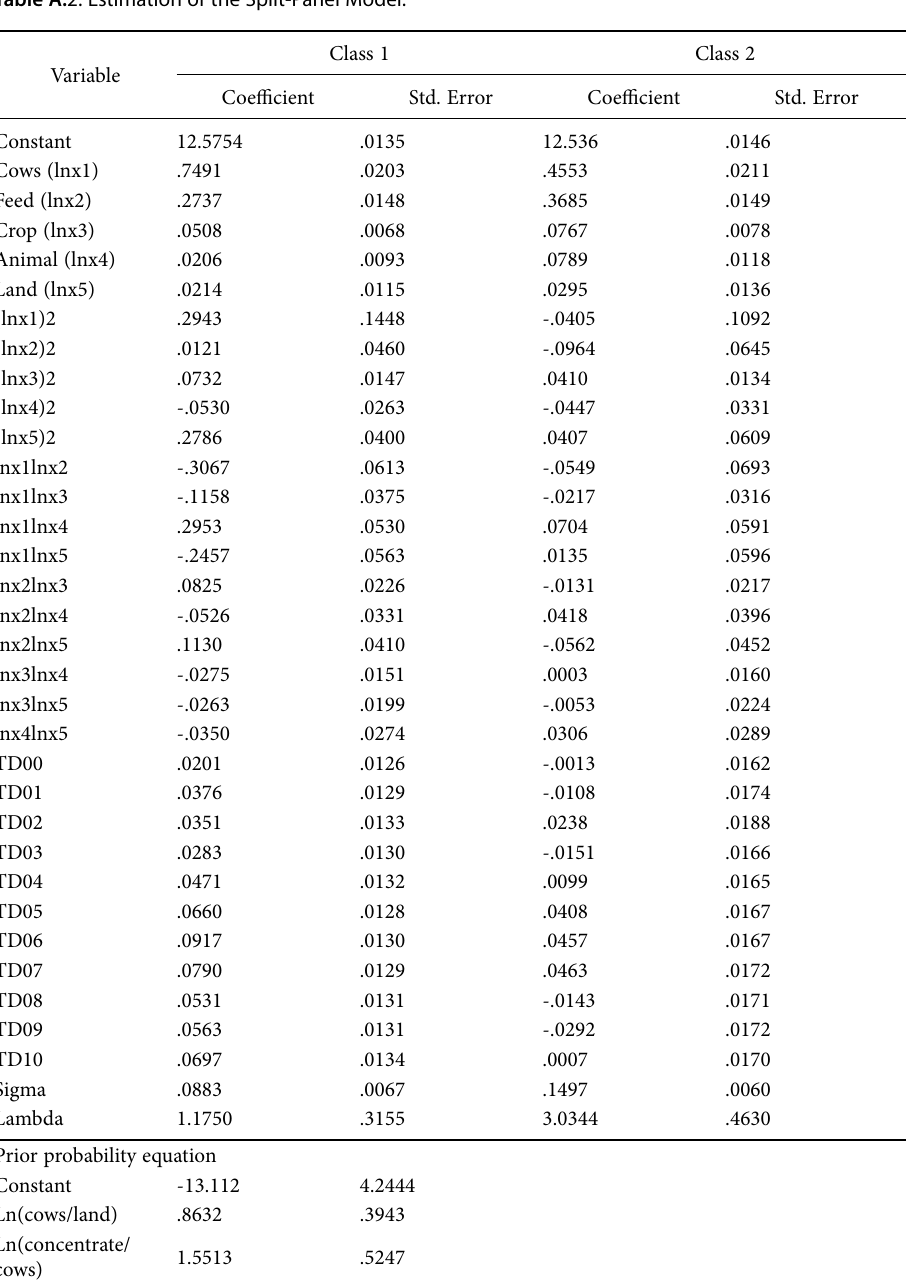
Table A. 2. Estimation of the Split-Panel